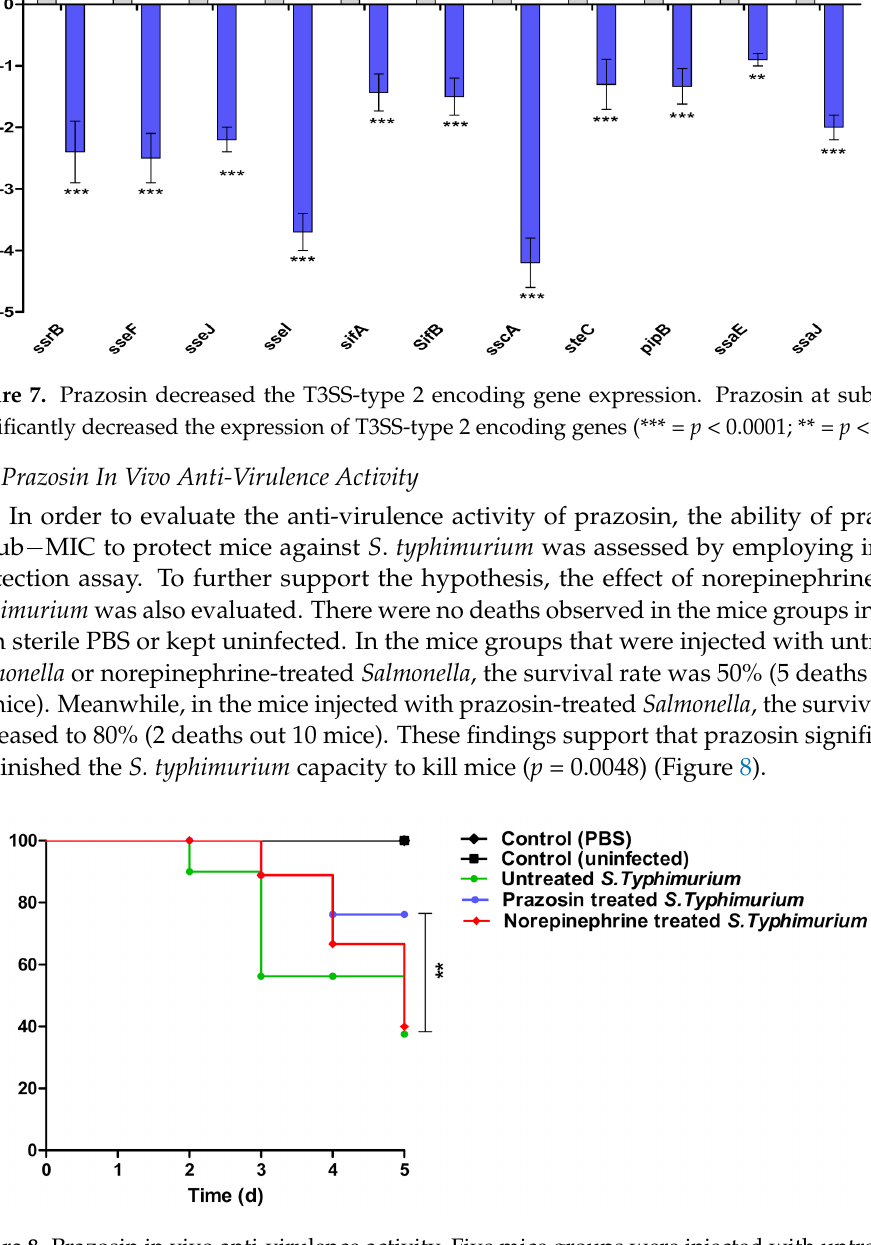
Figure 8. Prazosin in vivo anti-virulence activity. Five mice groups were injected with untreated S. Typhimurium, norepinephrine-treated S . typhimurium , Prazosin-treated S . typhimurium , PBS, or kept non-injected. Prazosin significantly decreased the capacity of S . typhimurium to kill mice (from 50% to 20%), Log-rank test for trend p = 0.0048 (** = p <